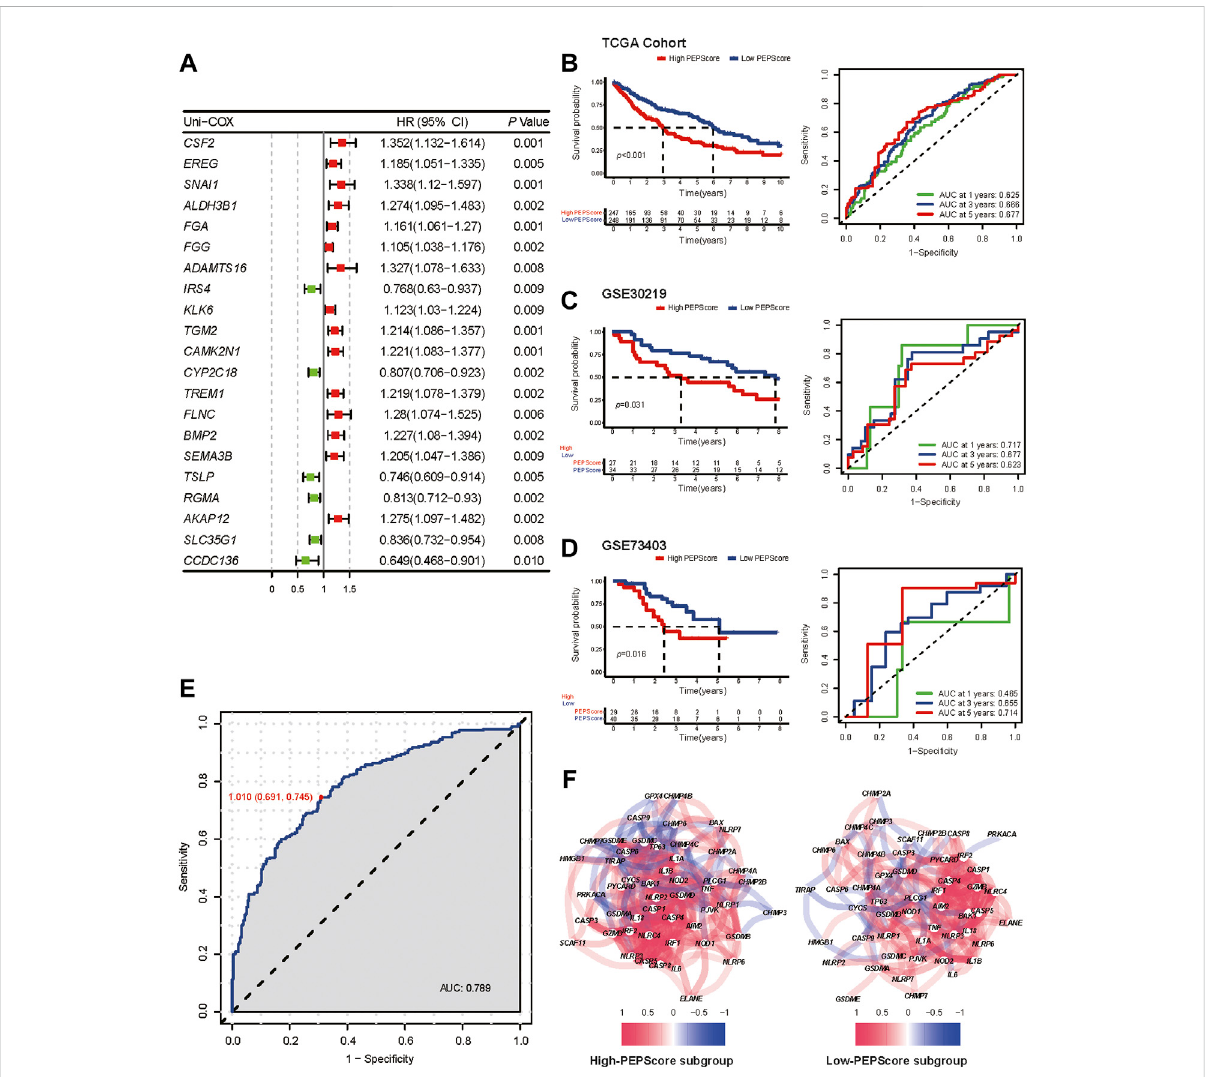
FIGURE 3 Prognostic value and the characteristics of different PEPScore subgroups. (A) The forest plot depicts the result of univariate Cox analysis on 21 pyroptosis-related hub genes. (B) Kaplan-Meiersurvival analysis and ROC curves forpatientsintheTCGA cohortto identifytheprognosticpower of the PEPScore. (C and D) Kaplan-Meier survival analysis and ROC curves for patients in the GSE30219 and GSE73403 cohort to validate the prognostic power of the PEPScore. (E) ROC curve showing the speci fi city and sensitivity for PEPScore to predict the pyroptosis expression patterns. (F) The co-expression network of the pyroptosis-related genes in the high-PEPScore subgroup and low-PEPScore